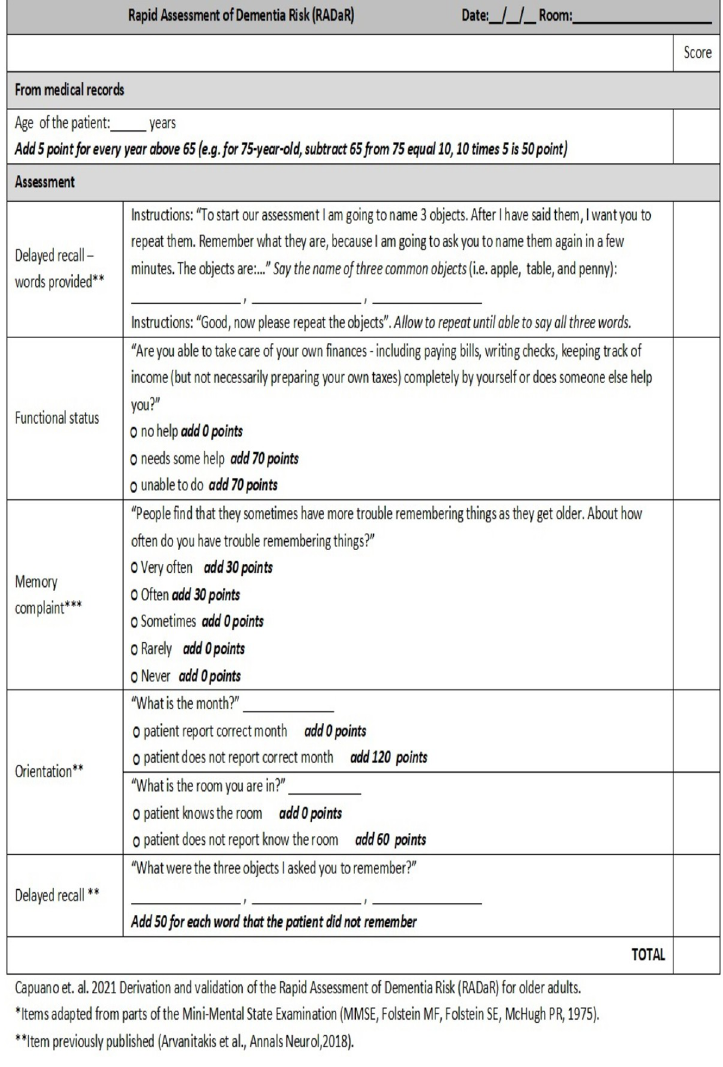
Fig 1. RADaR form. Form to calculate the Rapid Assessment of Dementia Risk (RADaR) for 65 years of age and older. Table 2 shows the results in the derivation cohort from the final Fine-Gray sub-distribution hazard regression model for the cumulative incidence of dementia, and with death (without dementia) as a competing risk. Fig 2 shows the time-specific AUC from 1 to 10 years. The dis- crimination of the scoring system was also consistently better than using the complete scale of the MMSE (Fig 2). A prediction of 3 years seems adequate for the RADaR, from both a clinical and a statistical perspective. The discrimination of the scoring system at 3 years was good as indicated by the performance for derivation and validation cohorts (AUC = 0.82 to 0.86), 3 year as well as all cohorts combined (AUC = 0.83, 95%CI = 0.81, 0.85). 3 year Because age alone is highly discriminating for dementia, we repeated the analyses with the entire sample to compare the performance of the RADaR with age alone (AUC = 0.74, 3 year 95%CI = 0.71, 0.76). Fig 3 compared the ROC curve of age as a sole predicting variable and the